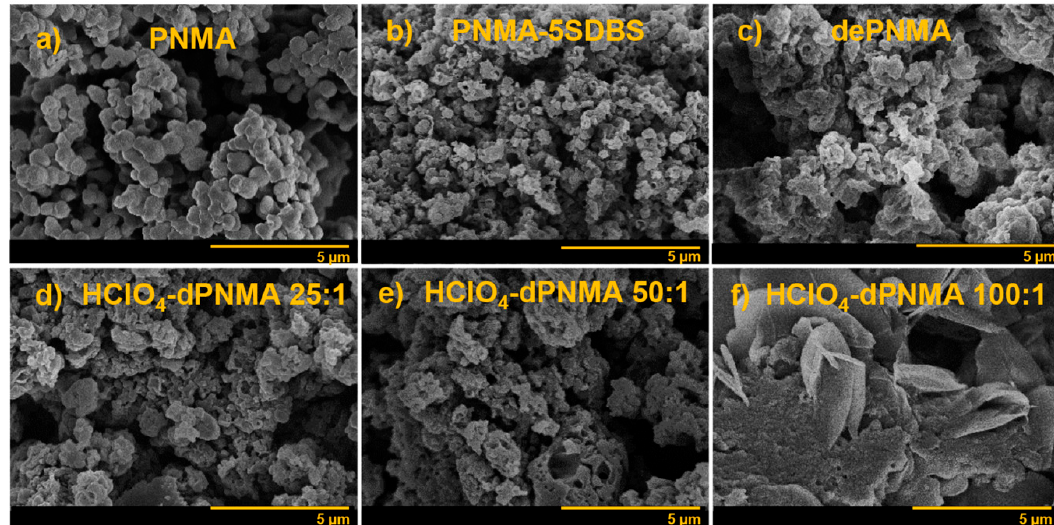
Figure 6. Morphology of PNMA synthesized with different synthesis conditions: ( a ) PNMA (without surfactant); ( b ) PNMA-5SDBS (before the de-doping step); ( c ) dePNMA (after the de-doping step); after the re-doping step at various doping mole ratios; ( d ) HClO 4 -dPNMA 25:1; ( e ) HClO 4 -dPNMA 50:1; and ( f ) HClO 4 -dPNMA 100:1.